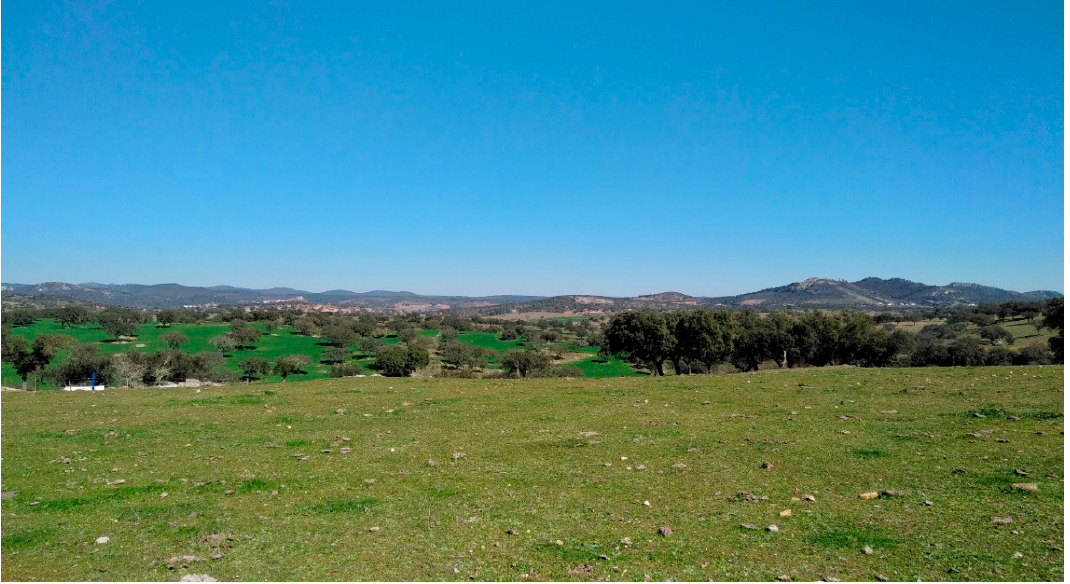
Figure 4. Overgrazing of the agricultural landscape—the river corridor is in the valley (author: Kaletová, 2018). Int. J. Environ. Res. Public Health 2019 , 16 , x FOR PEER REVIEW